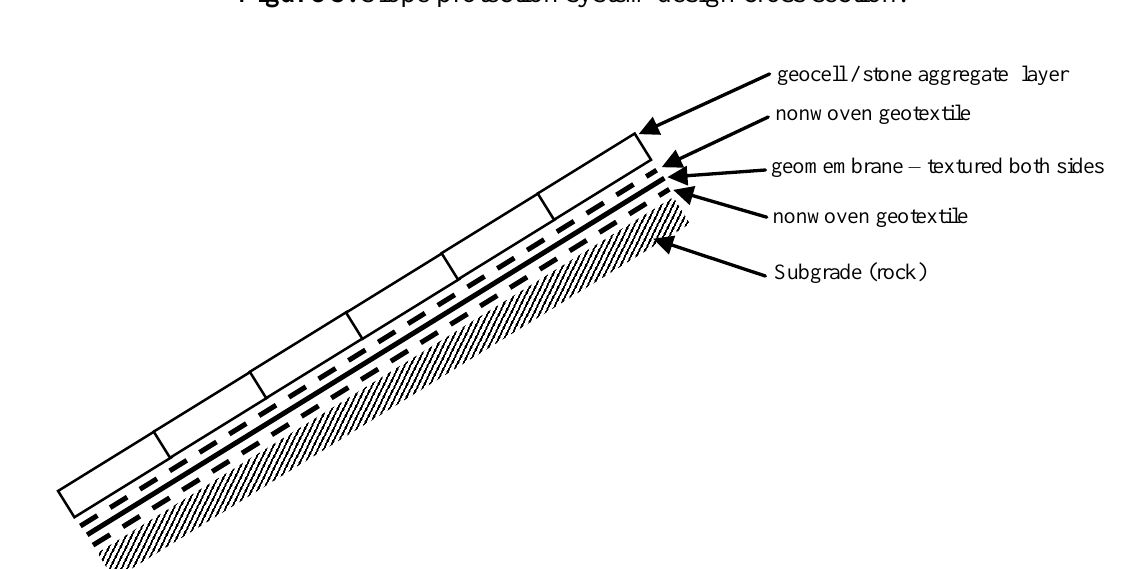
Figure 3. Slope protection system design cross